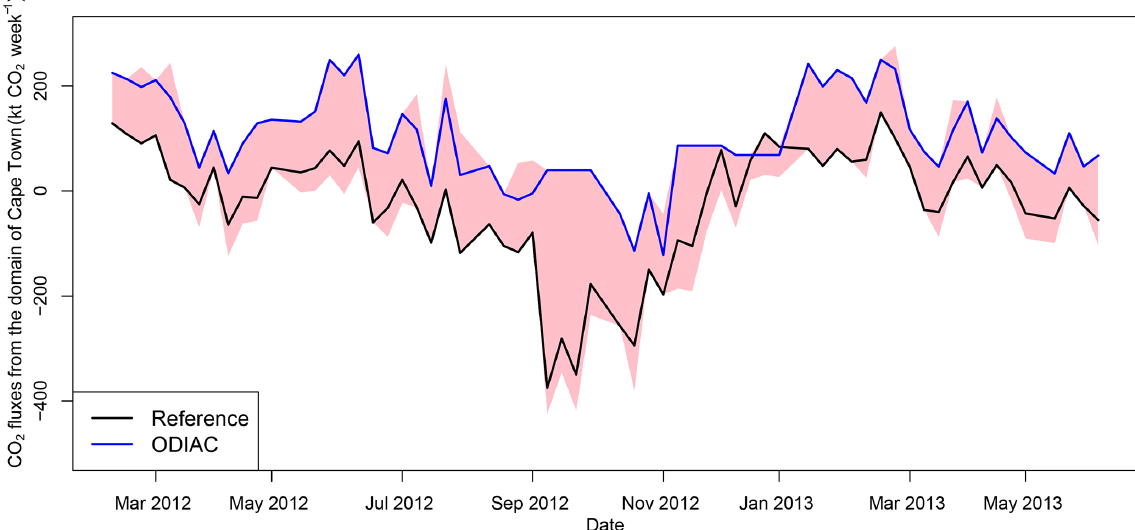
Figure 9. Using the posterior estimates of the reference and ODIAC inversions (S0 and S2) and the direction of change from the prior estimate, a region is inferred showing where exactly the true aggregated flux is expected to lie (indicated by the shaded pink